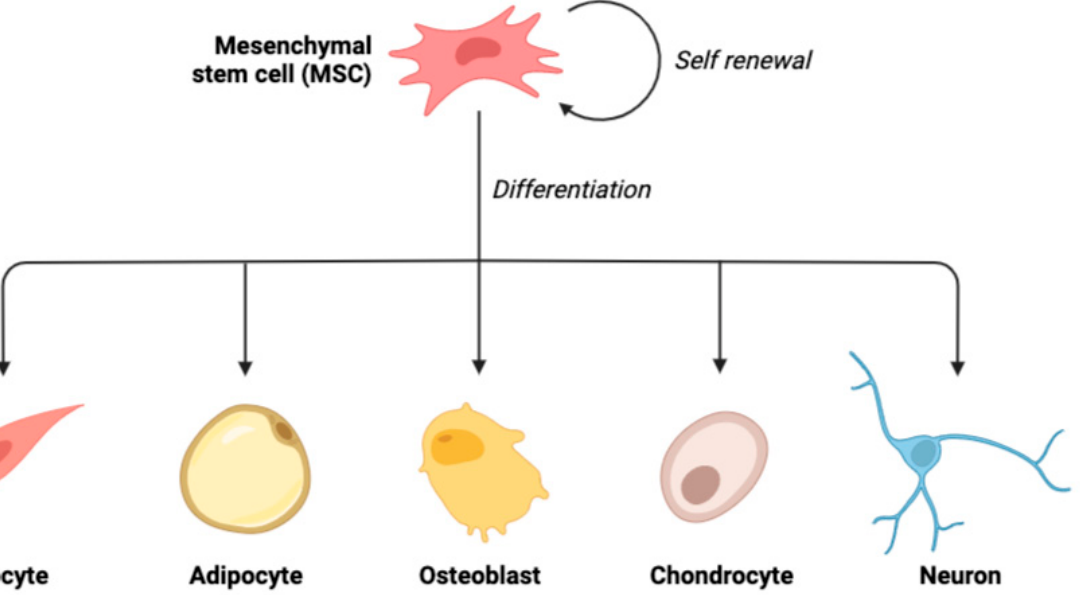
Figure 1. Schematic illustration of the ability of mesenchymal stem cells to undergo multilineage differentiation.